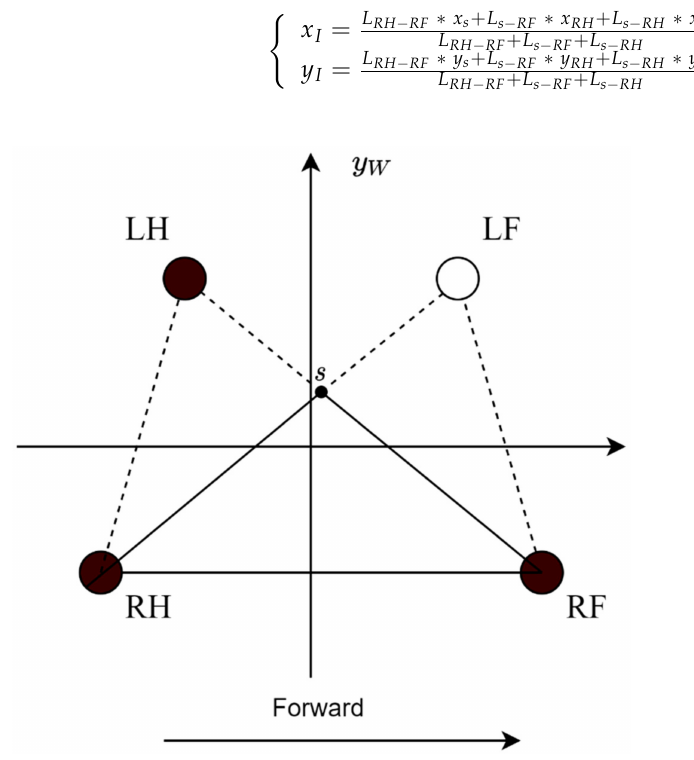
Figure 5. Figure showing the coordinates of projection in the world coordinate